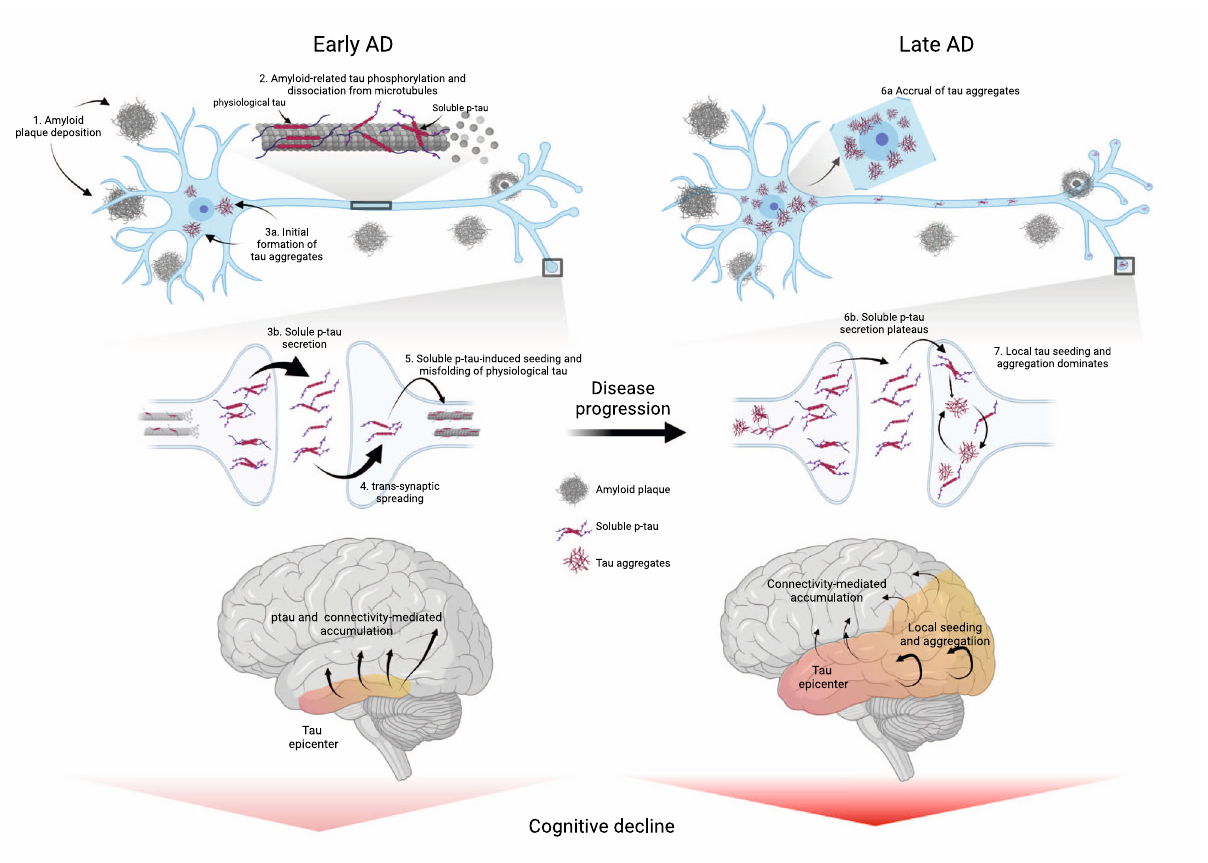
Fig. 6 | Proposedmodeloftaupathology accumulationin Alzheimer ’ s disease. InearlyAD,solubleorinsolubleA β triggersincreasedconcentrationsandsecretion of soluble p-tau, followed by post-synaptic uptake of p-tau seeds that lead to tau misfolding and aggregation. In late stages of the disease, when soluble p-tau